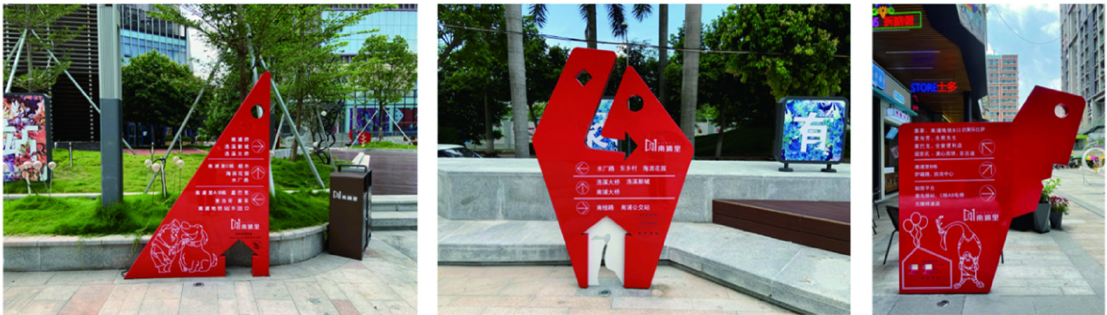
Figure 15. Current situation of the visual guidance system of Nanpu Times.